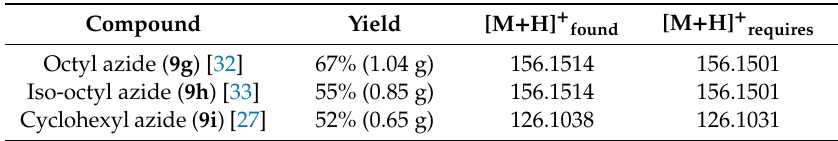
Table 4. MS Data for alkyl azides ( 9g–i ).